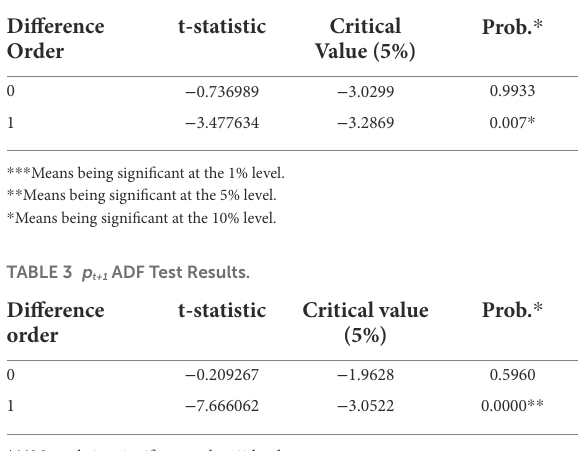
TABLE 6 Residuals of the unit root test Results. TABLE 2 Ln(y) ADF Test Results.